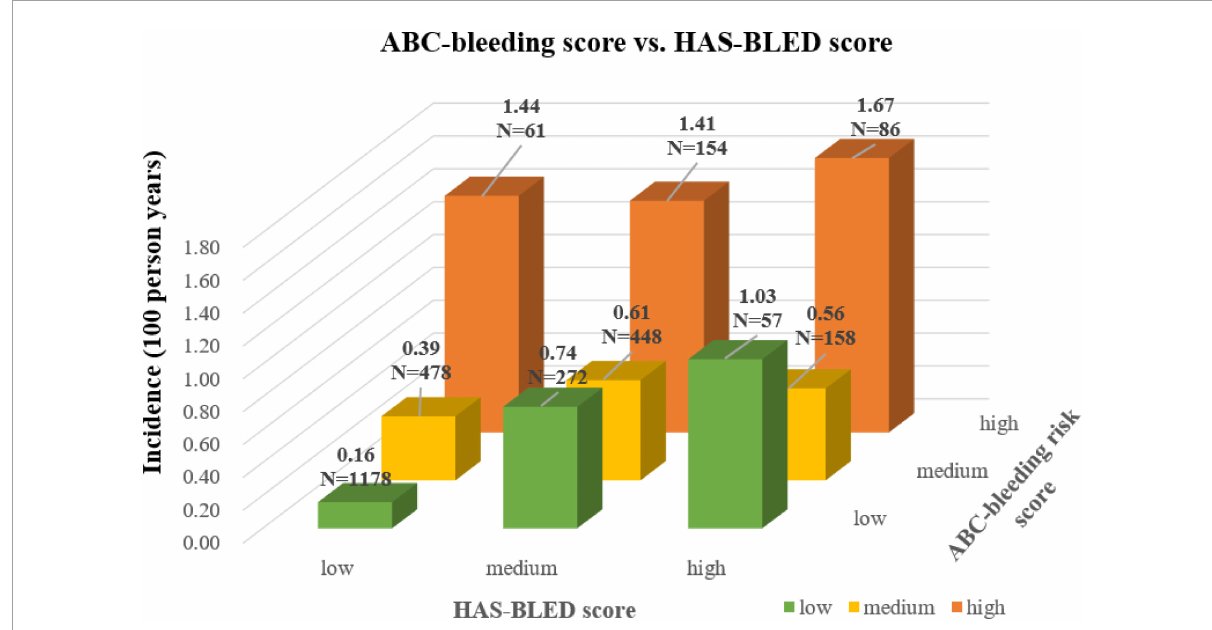
FIGURE2 Cross-tabulation showing major bleeding incidence stratified by the ABC-bleeding risk and the modified HAS-BLED scores. The risk level shown by the color of column was assigned based on the modified HAS-BLED